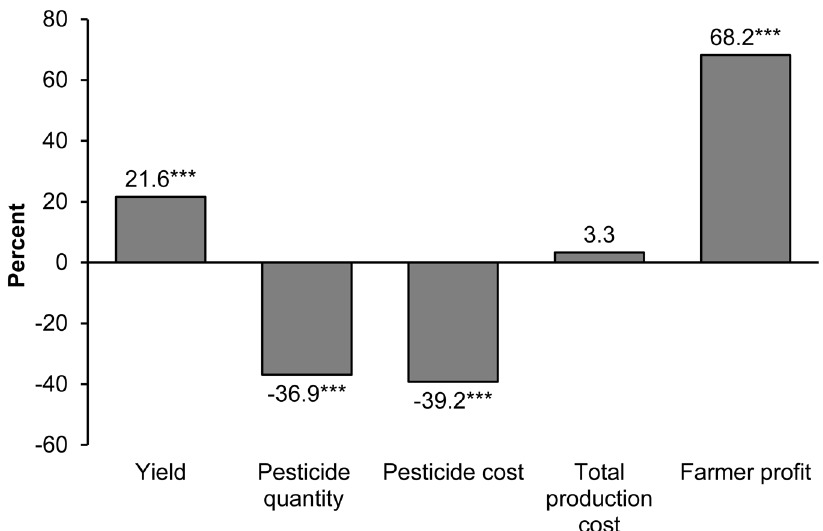
Figure 2. Impacts of GM crop adoption. Average percentage differences between GM and non-GM crops are shown. Results refer to all GM crops, including herbicide-tolerant and insect-resistant traits. The number of observations varies by outcome variable; yield: 451; pesticide quantity: 121; pesticide cost: 193; total production cost: 115; farmer profit: 136. *** indicates statistical significance at the 1% level.